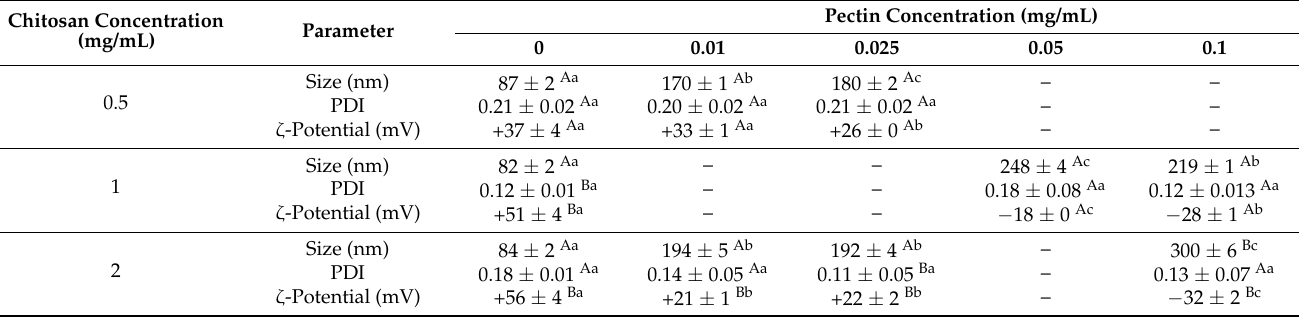
Table 1. Effect of pectin on size, PDI and ζ -potential of hollow zein particles coated with chitosan. Chitosan Concentration (mg/mL)